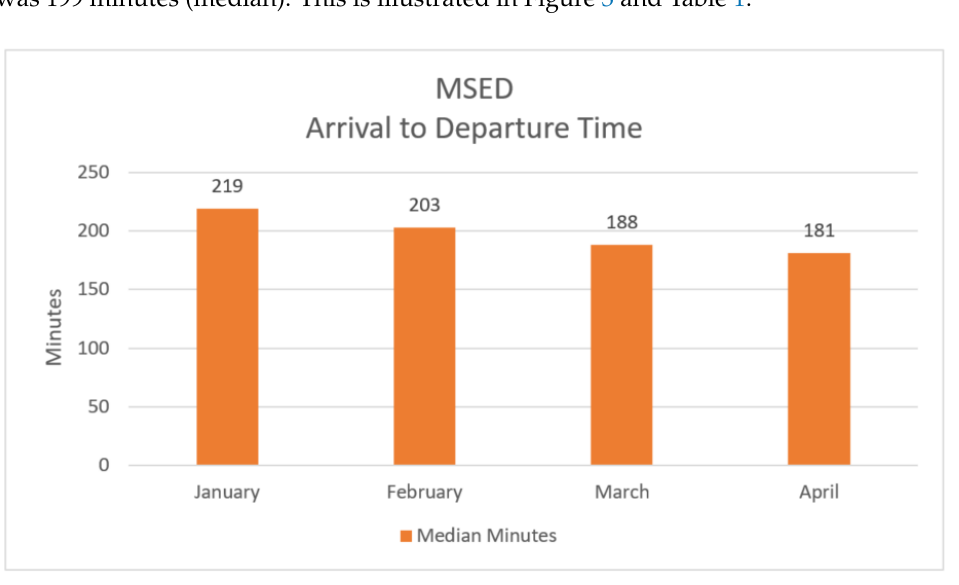
Figure 3. MSED patients arrival to departure time, first quarter, 2021. Table 1. MSED patients count and arrival to departure time.